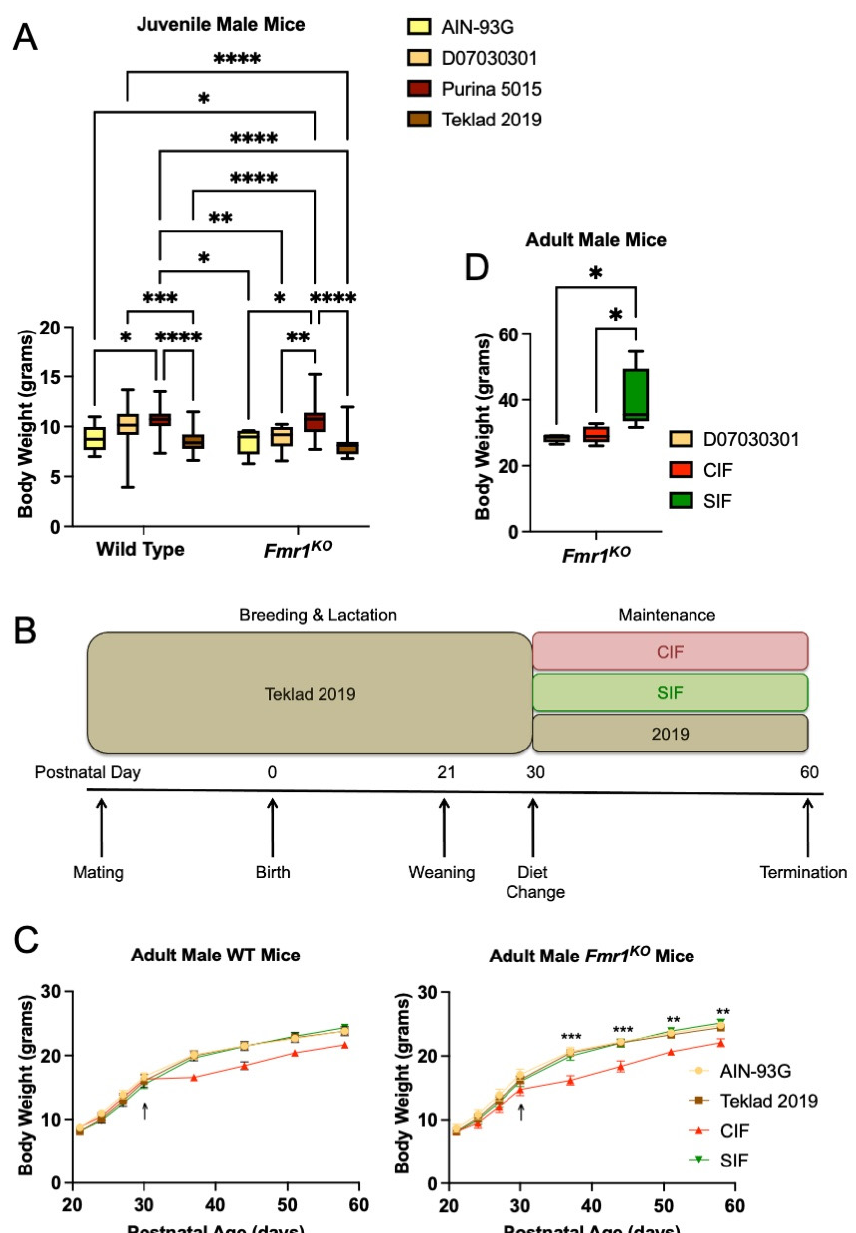
Figure 1. Mouse body weight as a function of Fmr1 genotype and diet. ( A ) Body weight of juvenile WT and Fmr1 KO male mice in response to rodent diets. Cohorts include WT/AIN-93G ( n = 10), WT/D07030301 ( n = 80), WT/Purina 5015 ( n = 29), WT/Teklad 2019 ( n = 29), Fmr1 KO /AIN-93G ( n = 7), Fmr1 KO /D07030301 ( n = 17), Fmr1 KO /Purina 5015 ( n = 32) and Fmr1 KO /Teklad 2019 ( n = 23). Mice were maintained on the indicated diets throughout gestation and lactation and weighed on postnatal day 21 (P21) immediately prior to seizure testing and average weight in grams with SEM ( y -axis) plotted against genotype ( x -axis). Statistics were determined by 2-way ANOVA and Tukey’s multiple comparison tests denoted by p < 0.05 (*), p < 0.01 (**), p < 0.001 (***), and p < 0.0001 (****). Two ANOVA results include interaction F(3219) = 1.497, p = 0.22; genotype F(1219) = 2.544, p = 0.11; diet F(3219) = 23.68, p < 0.0001. ( B ) Schematic of experimental plan. ( B ) The experimental plan includes Fmr1 HET females were bred and maintained on Teklad2019 (grain-based but low phytoestrogen levels) diet throughout gestation and lactation. Male WT and Fmr1 KO pups were weaned at P21 and